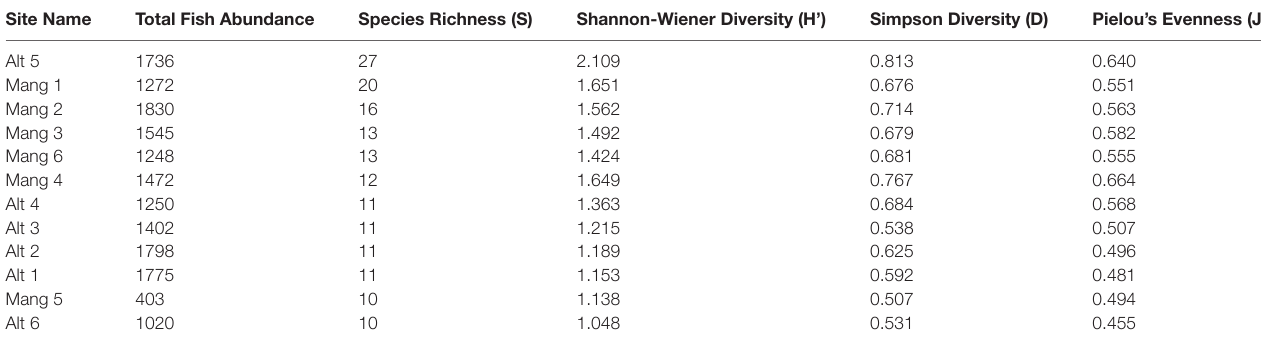
TABLE 2 | Univariate species richness, diversity, and evenness of each site. Sites are ordered by species richness in descending